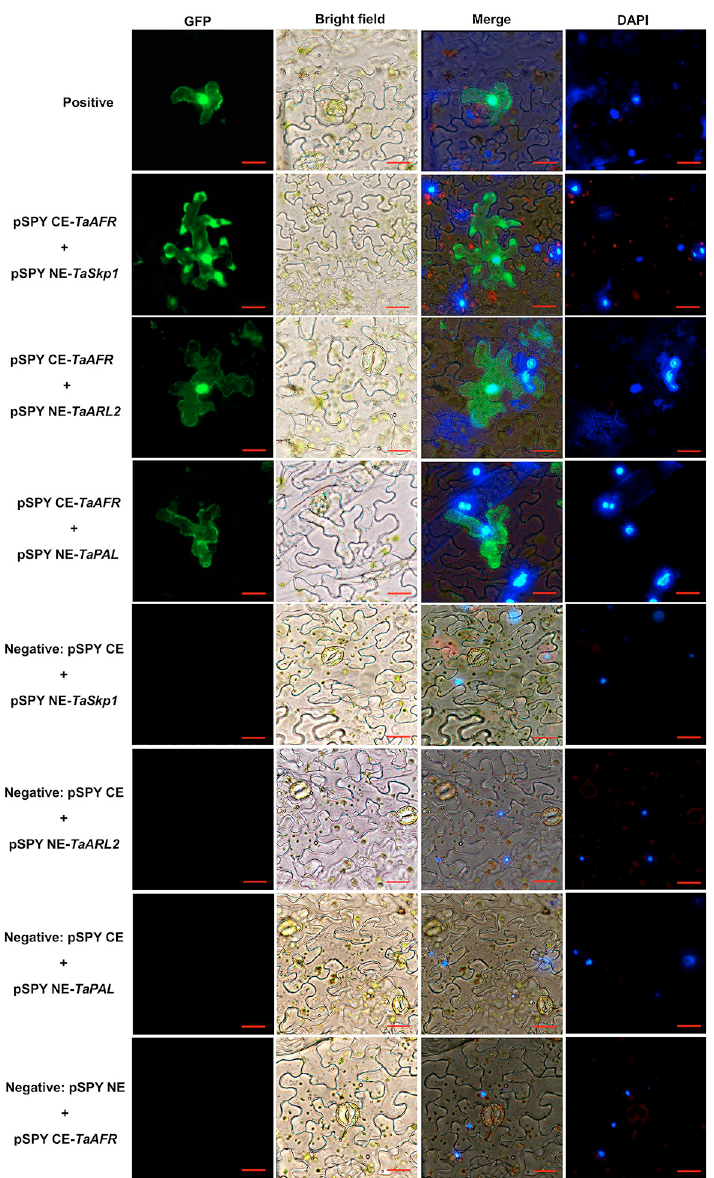
Fig 8. Verification of protein interactions by BiFC assay. The fluorescence microscope (Nikon Ti 2, Japan) with an excitation wavelength of 495 nm was used to observe fluorescence signal. Three independent experiments were conducted for each combination. Bar = 20 μ